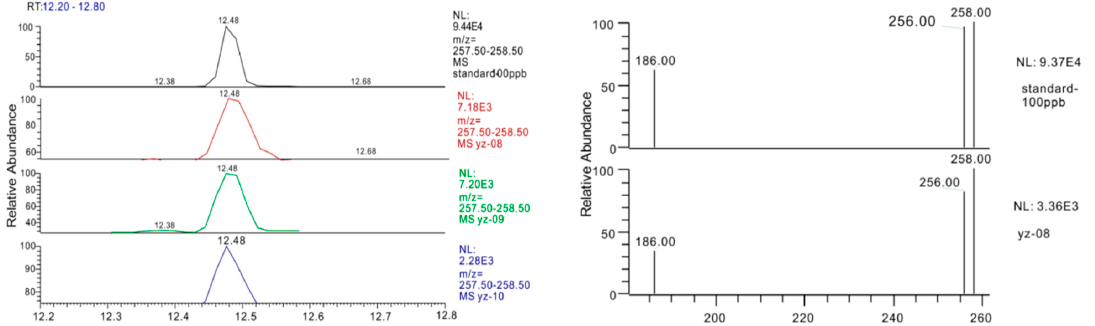
Figure 4. Comparison of chromatograms and mass spectra of PCB28 in a standard (100 ng/mL) and the samples.